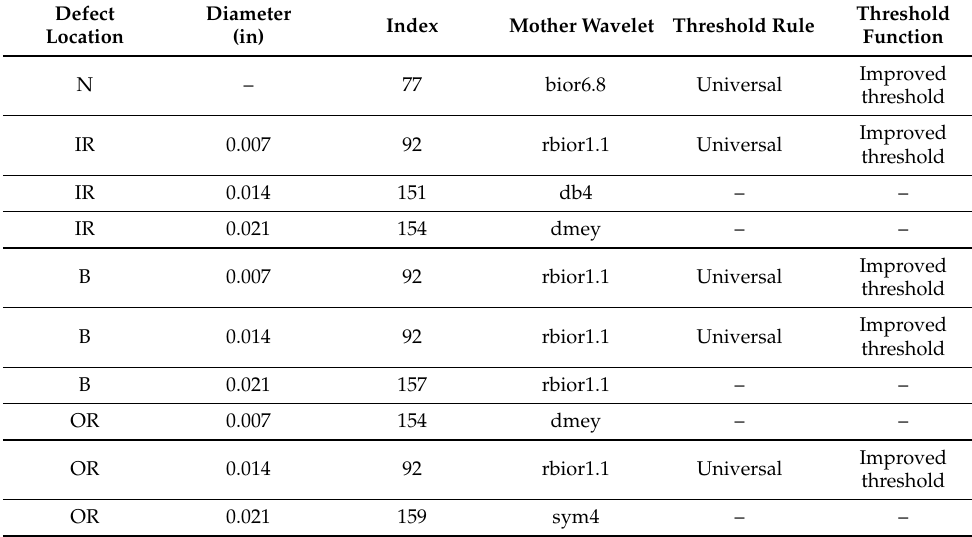
Table 5. Summary of denoising parameters that optimise kurtosis for different defect locations and